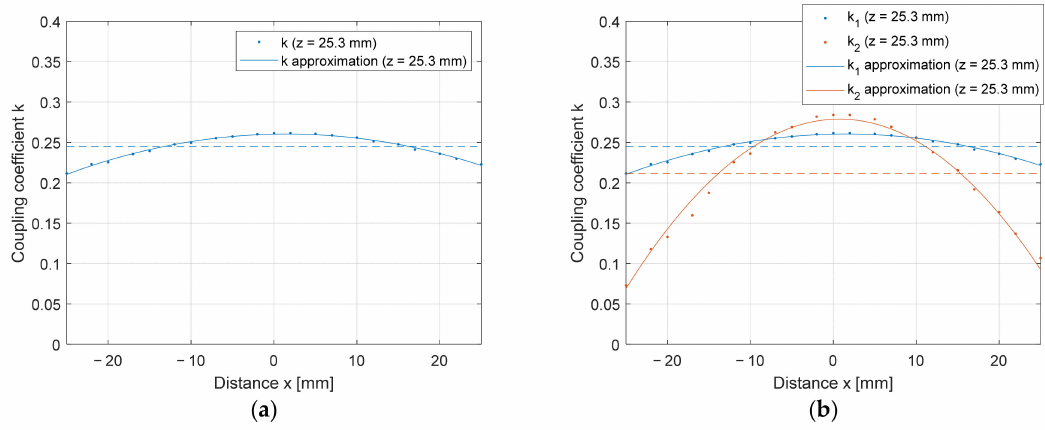
Figure 11. Coupling coefficient measurement along the x -axis at z = 25.3 mm: ( a ) single DD coil; ( b ) double DD coil.